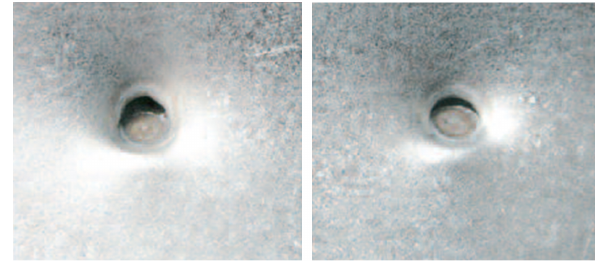
Figure 4: Failure of the spot welds after tensile test: a) H260 steel, b) H340 steel.